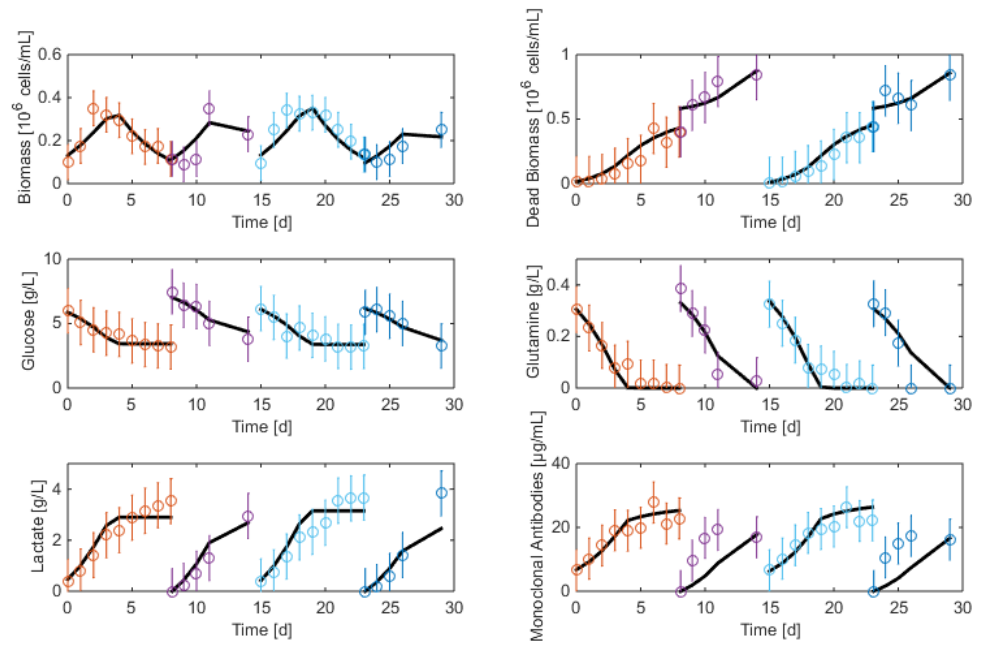
Figure 6. Direct validation of the reduced model with the first two data sets of the HB1 strain. The